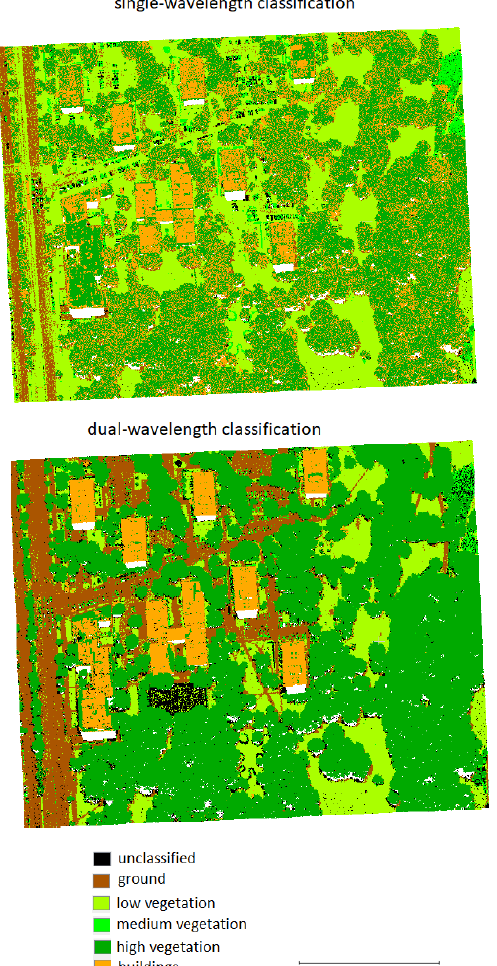
Fig. 5 Results of the road classification based on the dual- wavelength intensity information in OPALS and in TerraScan